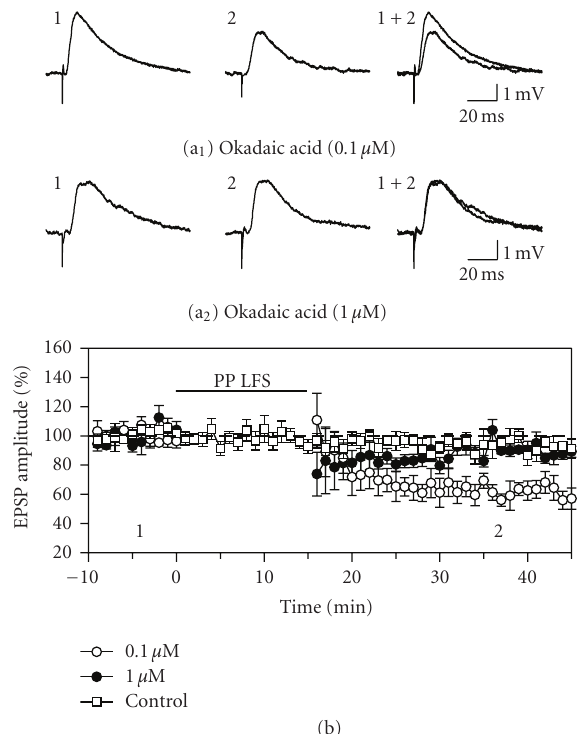
Figure 4: The induction of LTD was blocked in a dose-dependent manner by including okadaic acid in the recording electrode solution to block activation of protein phosphatase 1 (PP1). (a) and (b) A low concentration of 0.1 μ M okadaic acid failed to block LTD induction, but raising the concentration to 1.0 μ M resulted in a block of LTD induction (compare traces in A 1 versus A 2 ). Responses in control cells filled with 1.0 μ M okadaic acid that did not receive conditioning stimulation remained stable. The block of LTD by okadaic acid suggests that activation of PP1 mediates LTD in the entorhinal